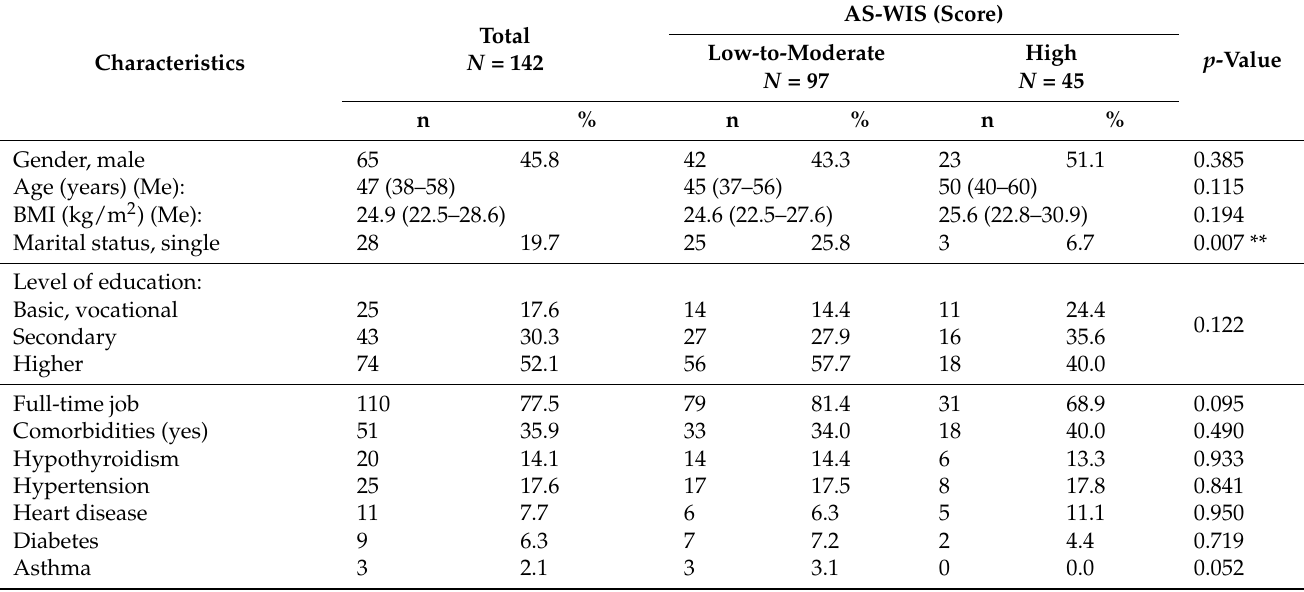
Table 4. The general and clinical characteristics of RA patients divided into two groups depending on the level of risk of work disability, n (%) or a median